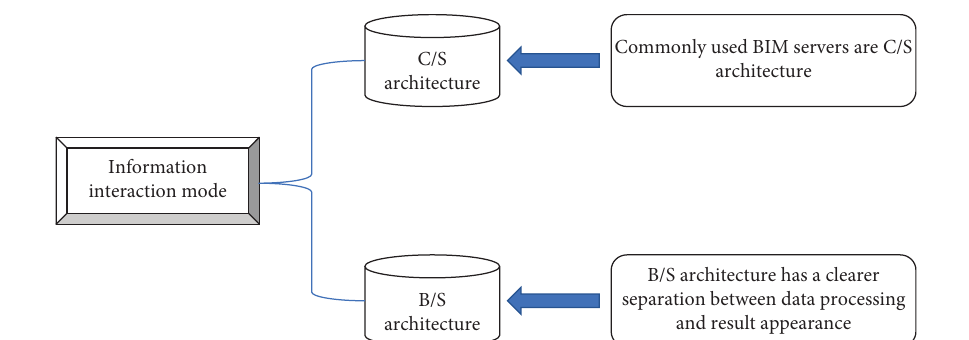
Figure 4: Architectures of information interaction mode.